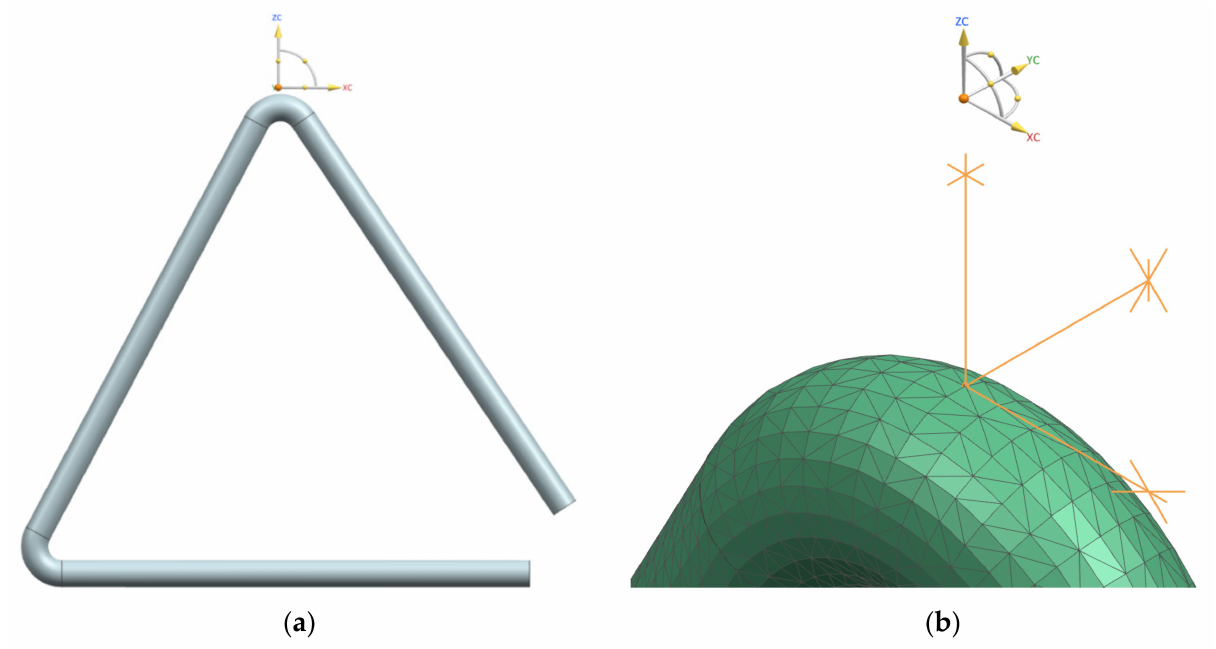
Figure 5. The modeling of the triangle using finite element analysis: ( a ) geometry of triangle; ( b ) meshing of the geometric model and blocked